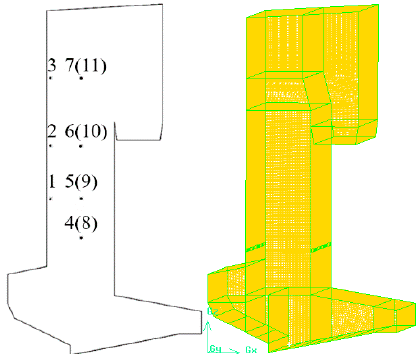
Figure 3. Measuring point position and mesh division.